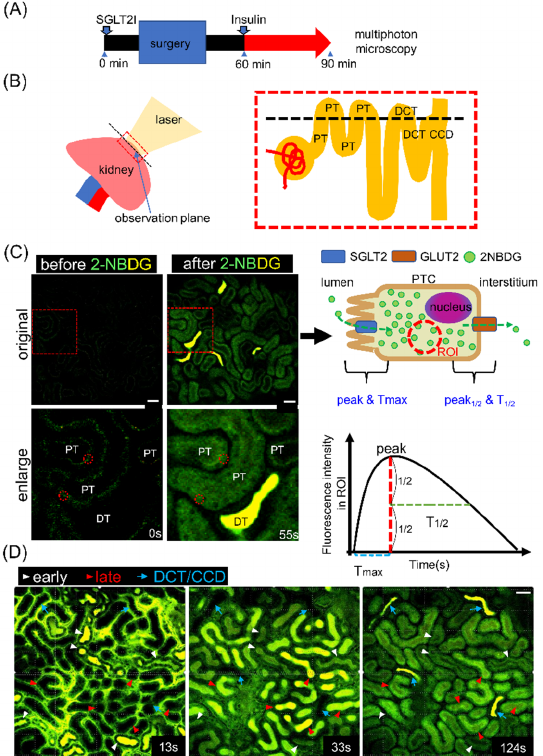
Figure 2. Intravital imaging for proximal tubule glucose uptake. ( A ) Protocol for the kidney experiment. Either vehicle or luseogliflozin was injected 90 min before 2-NBDG injection. Insulin was injected 30 min before injecting 2-NBDG. ( B ) The microscopic observation plane was at the superficial level of the kidney cortex that includes proximal tubules (PTs) near the glomerulus, PTs relatively far from the glomerulus, distal convoluted tubules (DCT), and collecting ducts (CCD). ( C ) In vivo image before and after 2-NBDG injection. Regions of interest (ROI) were set in the cytosol of PT cells (PTCs) (red dotted circles), and changes in fluorescence intensity were measured. 2-NBDG at a low level was depicted as green, while a saturated level of 2-NBDG was depicted as yellow (green and red). ( D ) In vivo images at different time points after 2-NBDG injection (13, 33, and 124 s). The image on the left (13 s) shows 2-NBDG in the lumen of early segments of PT and peritubular capillaries (white arrows). The image at the center (33 s) shows 2-NBDG in the lumen of late segments of PTs (red arrows) and in the cytosol of early segments. The image on the right (124 s) shows 2-NBDG in the lumen of DCT or collecting ducts (CDs) (blue arrow) and in the cytosol of PTC. The image before 2-NBDG injection was as dark as the image provided in C. Scale bar = 40 µ